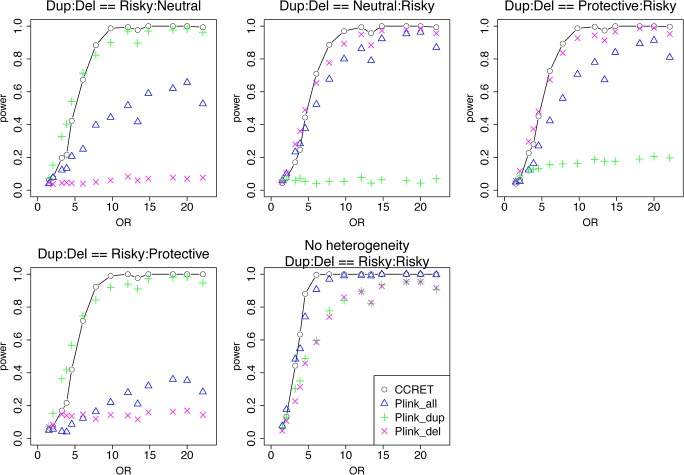
Power comparison between CCRET and PLINK 2-sided tests for simulation I-B: within-locus heterogeneity of the dosage simulation, under 5 heterogeneity models as detailed in section “Simulation Design”.Black O line: CCRET; Blue Δ: PLINK 2-sided test analyzing deletions and duplications combined; Green +: PLINK 2-sided test analyzing only duplications; Magenta x: PLINK 2-sided test analyzing only deletions.